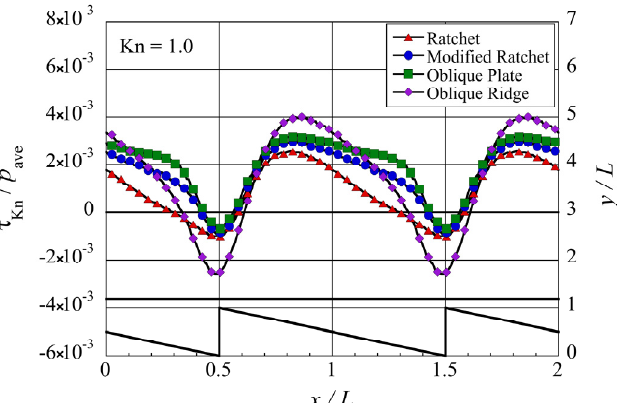
Figure 6. Distribution of the local tangential Knudsen stress, i.e., local propulsive force per unit area, for each case of the microstructure, at Kn = 1 . The silhouette of the ratchet structure is added for easy reference.